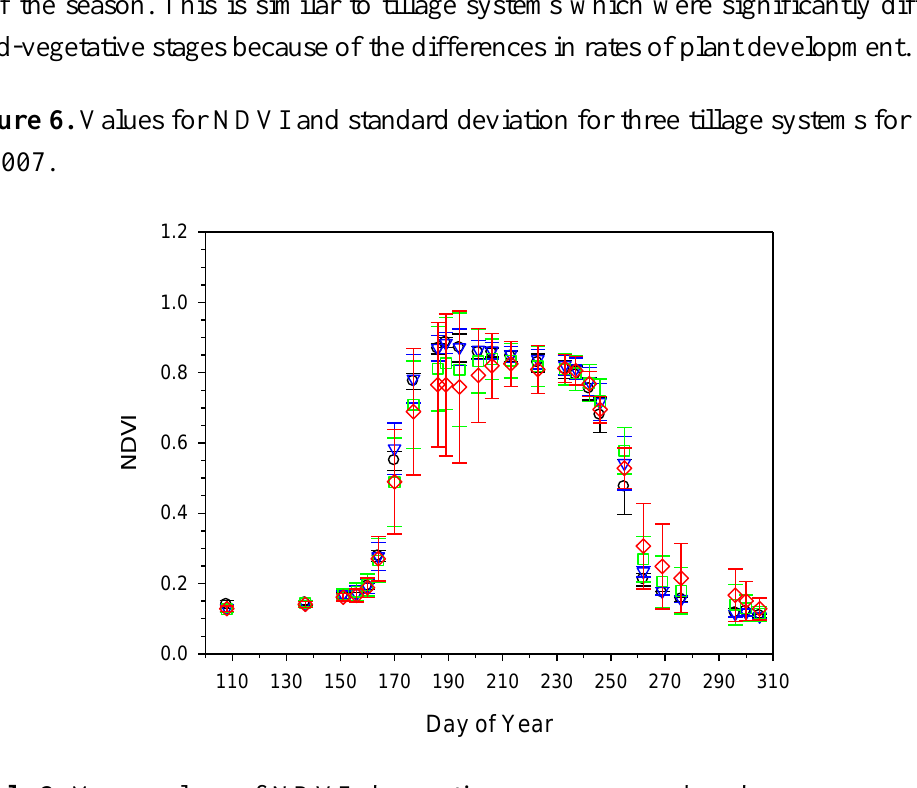
Table 2. Mean values of NDVI observations over corn and soybean crops grown in four tillage systems for the period from 2002 to 2006 for four development periods and the ANOVA for the comparison of the treatments and